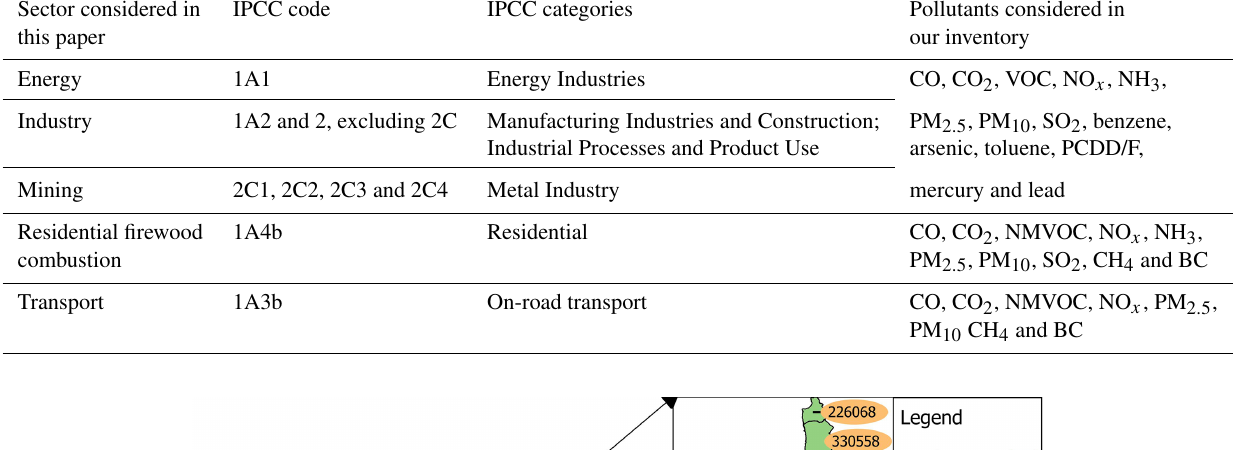
Table 1. Pollutants and sectors considered in the Chilean inventory (INEMA) according to IPCC (2006a) classification. Sector considered in